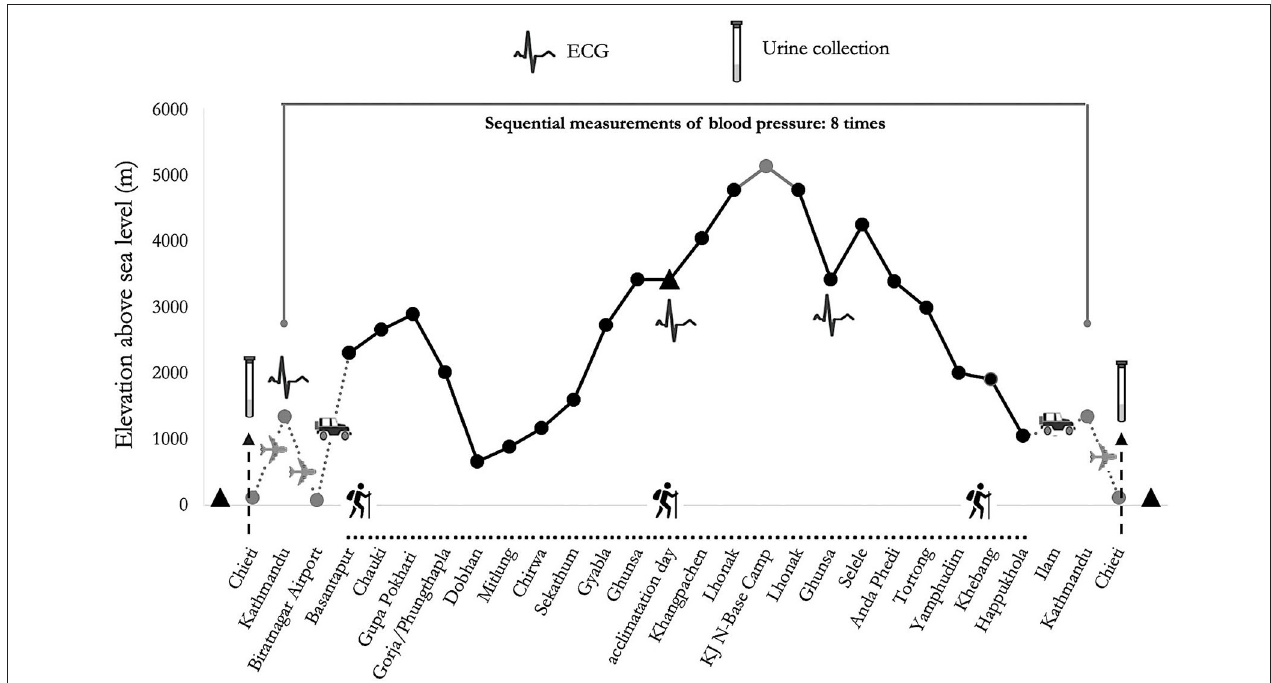
FIGURE 1 | Altimetric plan and measurement time of psychological tests of “Kanchenjunga Exploration and Physiology” project.